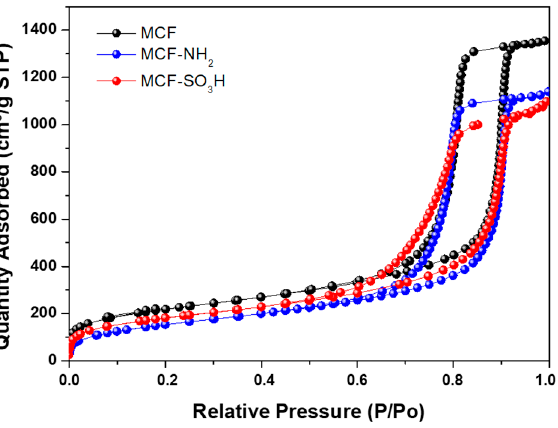
Figure 9. Nitrogen adsorption–desorption isotherms of MCF silica before and after modification with APTES (MCF-NH 2 ) and MPTMS (MCF-SO 3 H).